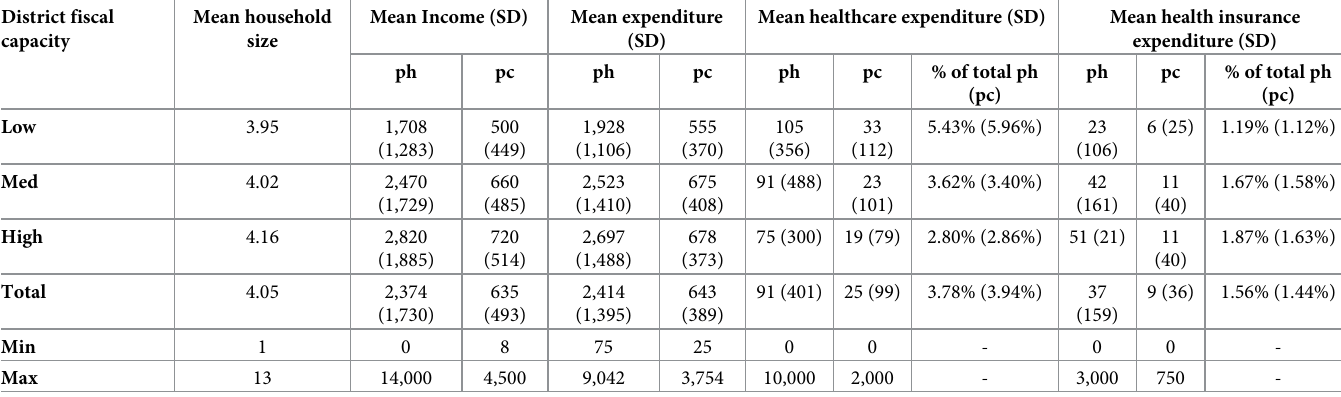
Table 3. The mean income and expenditure per household and per capita (IDR 000s) across districts. District fiscal capacity